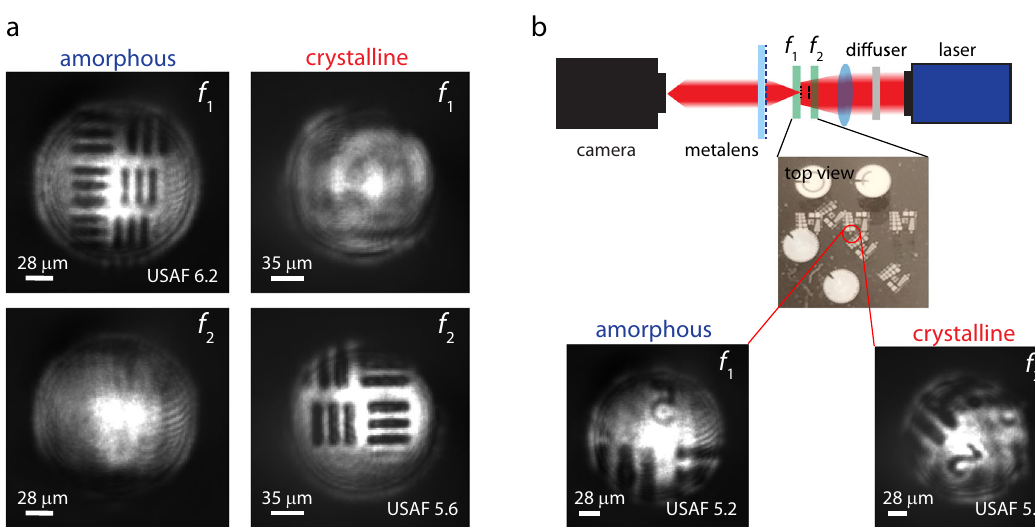
Fig. 5 Imaging using the GSST varifocal metalens. a Well-resolved lines of USAF-1951 resolution charts: the patterns have half periods close to the Rayleigh resolution limits of 7 µ m and 9 µ m in the a-state ( f 1 ) and c-state ( f 2 ), respectively. b Schematic of the setup for imaging multi-depth targets. Top- view photograph of the target consisting of two patterned samples overlapped at an angle of 45°. Camera images of the dual-depth target acquired by stationary metalens in a- and